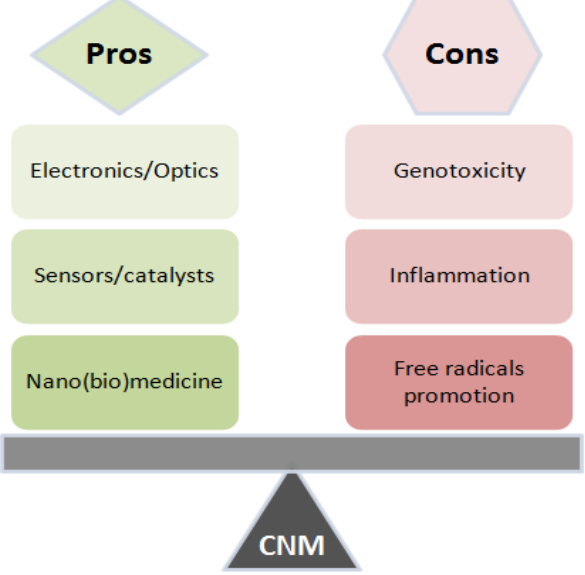
Figure 1. Pros and cons for the carbon nanomaterials (CNMs) use, original figure.